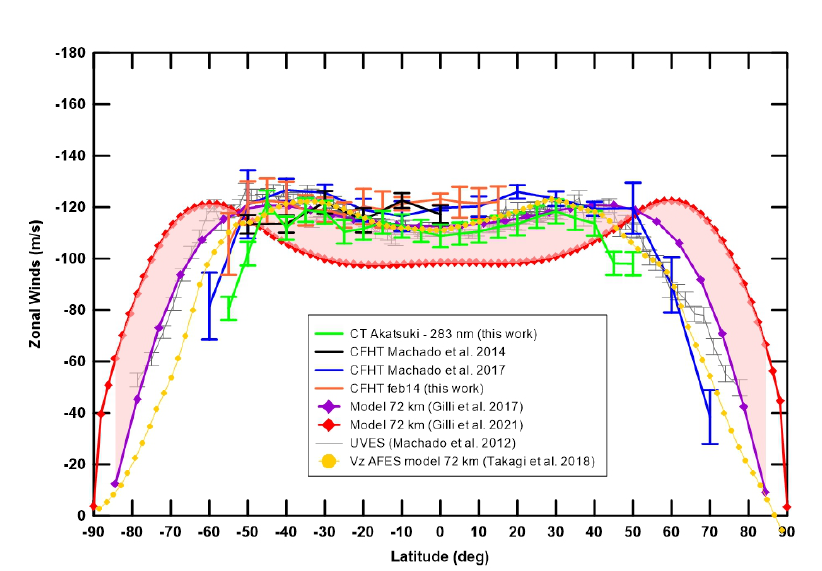
Figure 13. Comparison between predicted zonal wind profiles (IPSL-VGCM and AFES-Venus), cloud- tracked mean zonal wind latitudinal profiles at 283 nm (space-based: Akatsuki/UVI (this work)) and Doppler velocimetry zonal wind velocity latitudinal profiles (ground-based: VLT/UVES [11], CFHT/ESPaDOnS (Machado et al. [4,6] and this work)). Model profiles that best fit the observations are shown in a light red-coloured band (IPSL-VGCM) and in a yellow plot